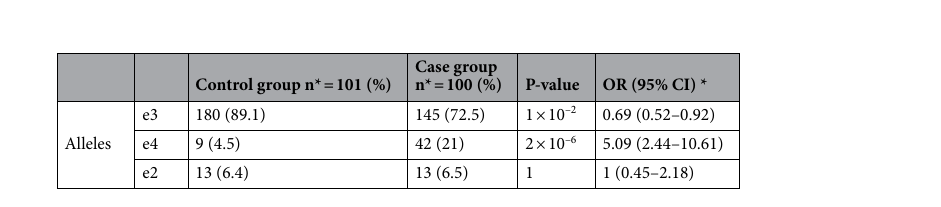
Table 2. Allele frequency in control and case groups. *n: sample number, OR: odds ratio, and CI: confidence intervals.